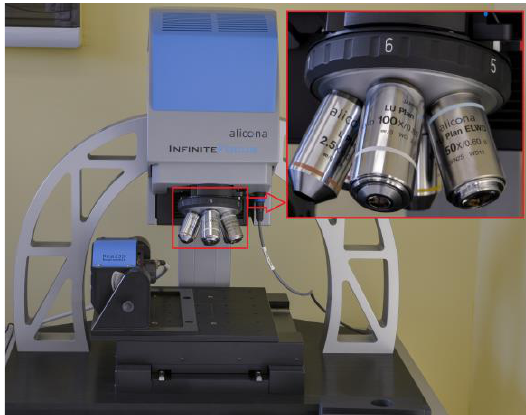
Fig. 4. Focus variation microscope InfiniteFocus® IF G4 produced by Alicona